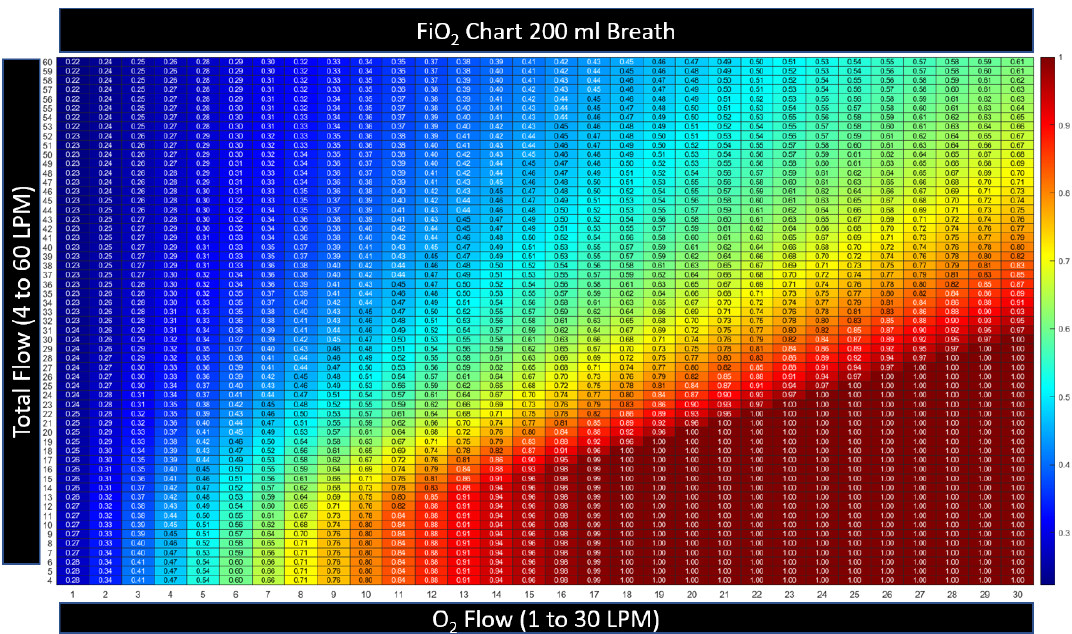
Figure 12. Applying HFNT to a shallow breath with a peak inspiratory flow (PIF) of 18 LPM illustrates clearly how to maximize the tracheal F i O 2 with settings. F i O 2 is maximized at each fixed O 2 flow rate when the total flow is equal to the PIF. Increasing the total flow setting dilutes the device F i O 2 and therefore the tracheal F i O 2 .